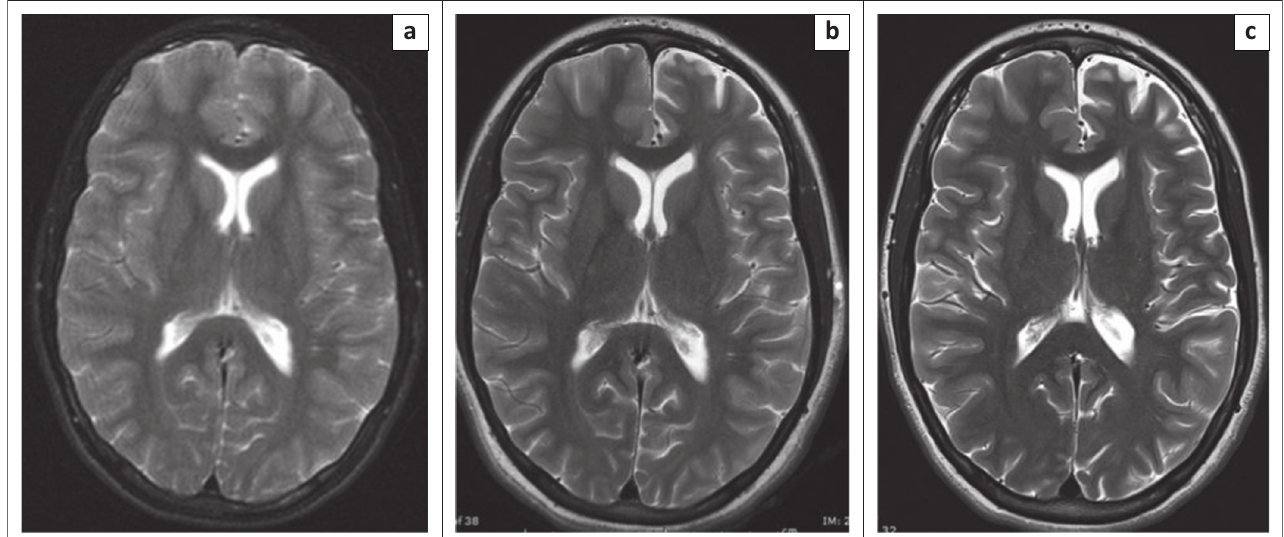
FIGURE 7: Twelve-year-old girl with drug-resistant complex partial seizures. Serial axial T2W images obtained at presentation (a) followed by serial studies at 1 year (b) and 2 years (c) after presentation show unilateral progressive frontal and temporal atrophy as indicated by prominence of the sulci and ventricles. Note that there is no appreciable signal abnormality in the caudate head, but the ipsilateral (left-sided) basal ganglia are slightly smaller than those on the right on all three images.